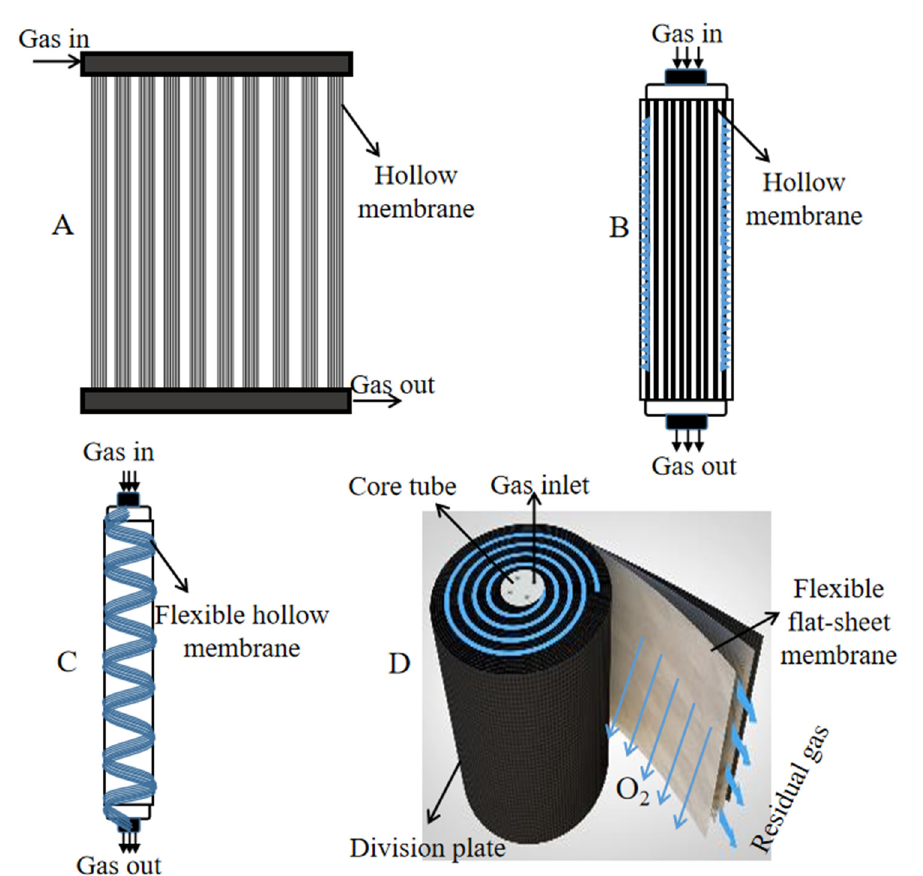
Figure 3. Different forms of membrane modules, ( A ) curtain membrane module, ( B ) tubular mem- brane module, ( C ) tube spiral membrane module, ( D ) flat sheet spiral membrane module.